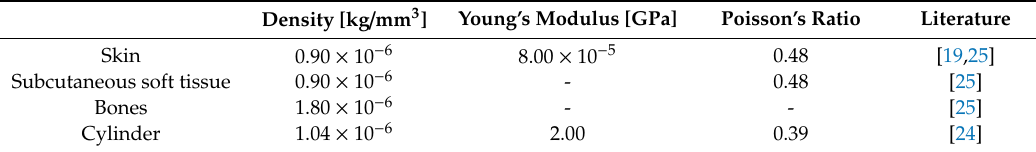
Table 2. Mechanical properties used in the hand FE model and cylinder FE